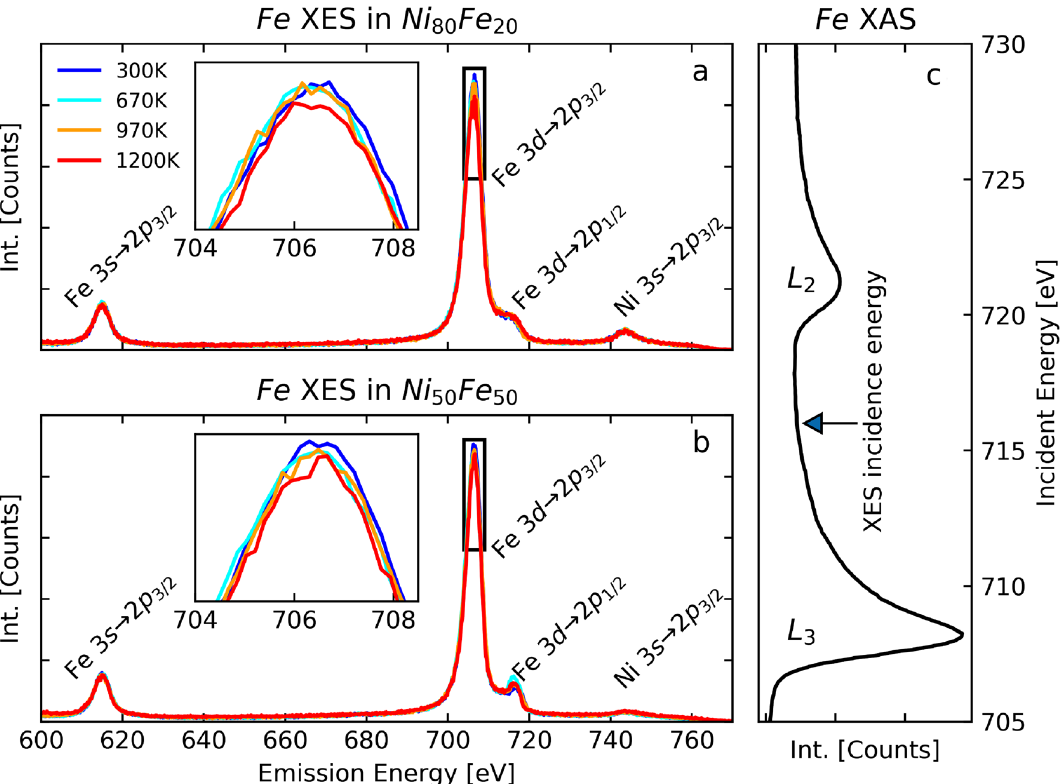
Figure 2. Temperature-dependent XES of iron. Temperature dependent Fe L -edge XES spectra in Fe 20 Ni 80 and Fe 50 Ni 50 are shown in ( a ) and ( b ) respectively. The inset are zoom in of the 3 d → 2 p 3 / 2 peak. An increase of the temperature leads to a reduction of intensity of the 3 d → 2 p 3 / 2 peak. ( c ) XAS spectrum of iron. The arrow indicates the photon energy used for the XES